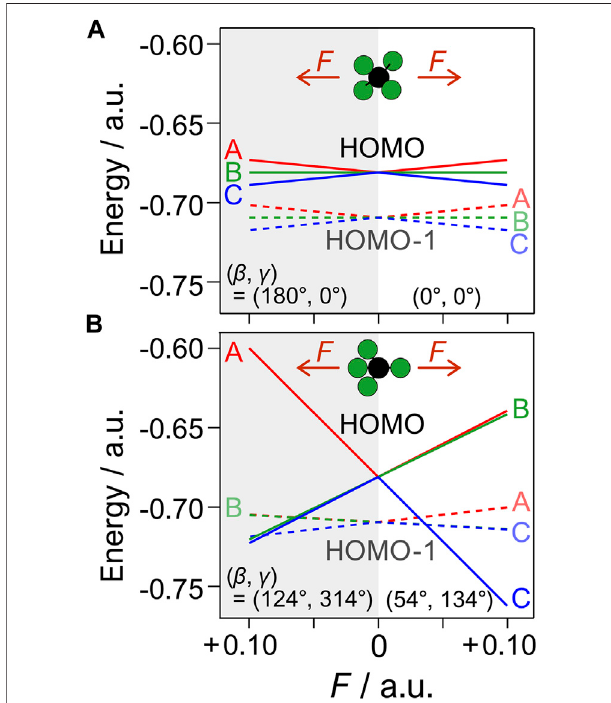
FIGURE 7 | Stark shifted energies of E 0, i ( F ) of eigenorbitals, ϕ i ( i = A, B, C), of HOMO (solid line) and HOMO-1 (dashed line) as a function of the static fi eld F (see Eq. 9 ) at four different molecular orientations with respect to F , de fi ned by the Euler angles ( β , γ ) in Figure 2 . (A) The electric fi eld is parallel to the molecular principal axis ( C 2 ), i.e., ( β , γ ) = (0 ° , 0 ° ) (right) and (180 ° , 0 ° ) (left). (B) The same as (A) but for ( β , γ ) = (54 ° ,134 ° ) (right) and (124 ° , 314 ° ) (left), where the electric fi eld is almost parallel to one of the C-F axes.